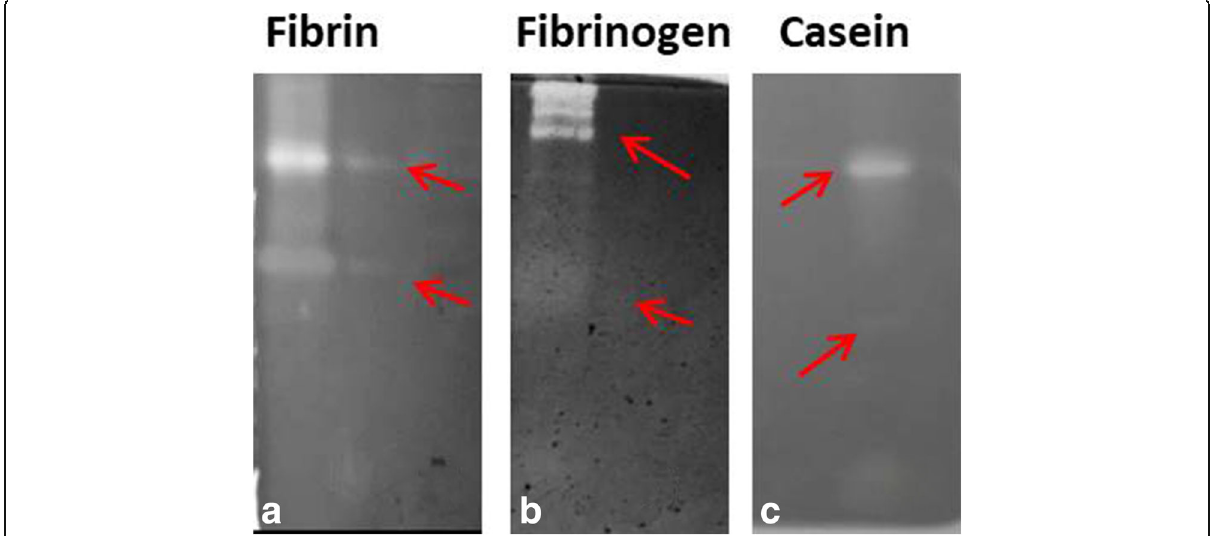
Fig. 5 Proteolytic activity of SCF using different substrates assayed using zymogram protease assay. Arrows in red indicate zones of digestion of protein substrates. a Fibrinolytic activity of SCF. b Fibrinogenolytic activity of SCF. c Caseinolytic activity of SCF. a Fibrinolytic activity of SCF (4 μ g/ ml) was assayed by copolymerizing fibrinogen and thrombin to yield fibrin in the acrylamide gel followed by incubation of the gel in incubation buffer for 1, 2, and 5 h incubation period at 37 °C. Fibrinolytic activity was observed at all three incubation intervals, seen as digestion of the substrate. The figure shows fibrinolysis by SCF after 1 h of incubation. b SCF (4 μ g/ml) digested fibrinogen copolymerized with the region of the zymogram gel. Activity was seen within 1 h of incubation at 37